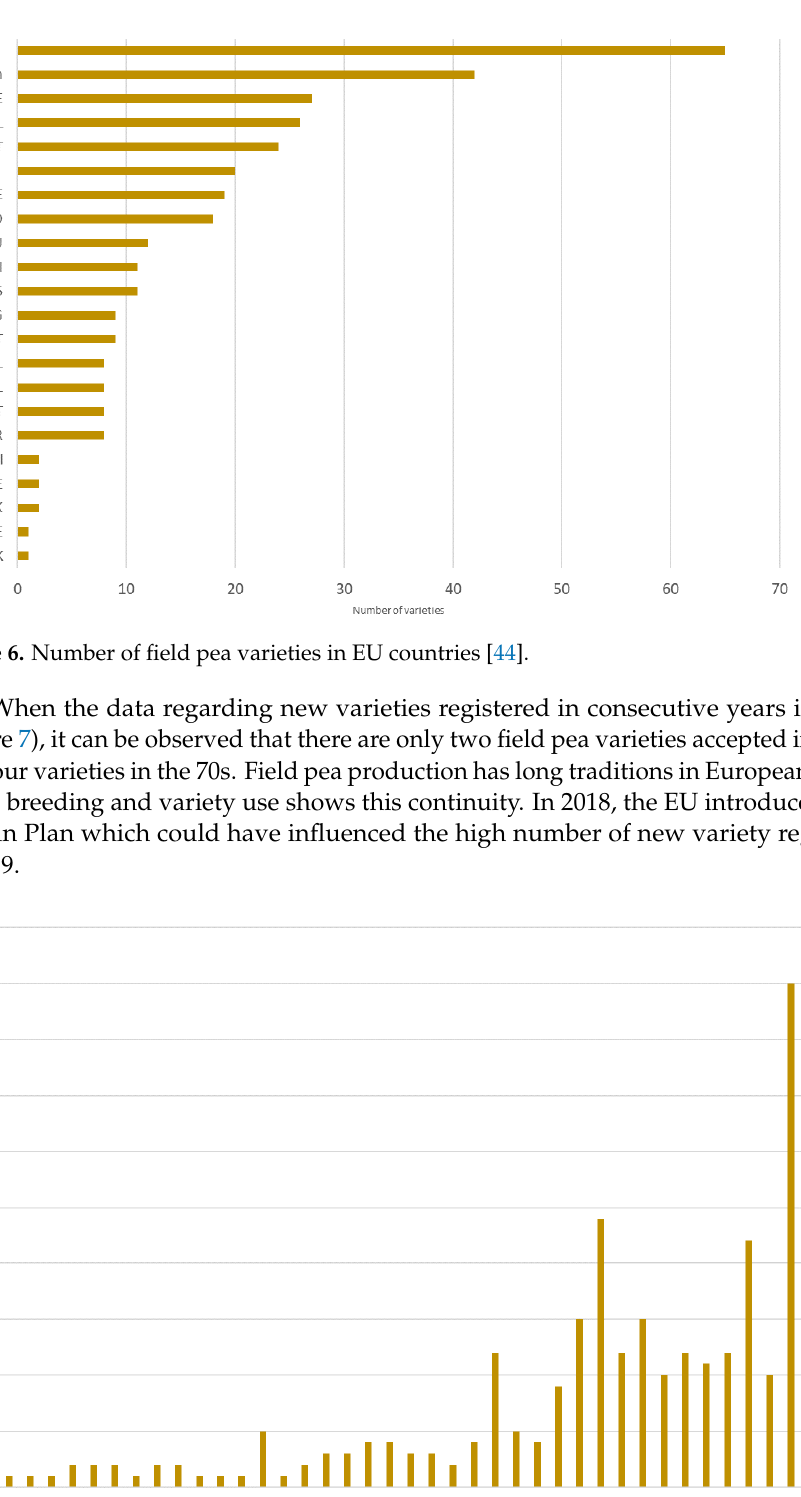
Figure 5. Harvested area of field pea in EU countries in 2000 and 2019 [46].